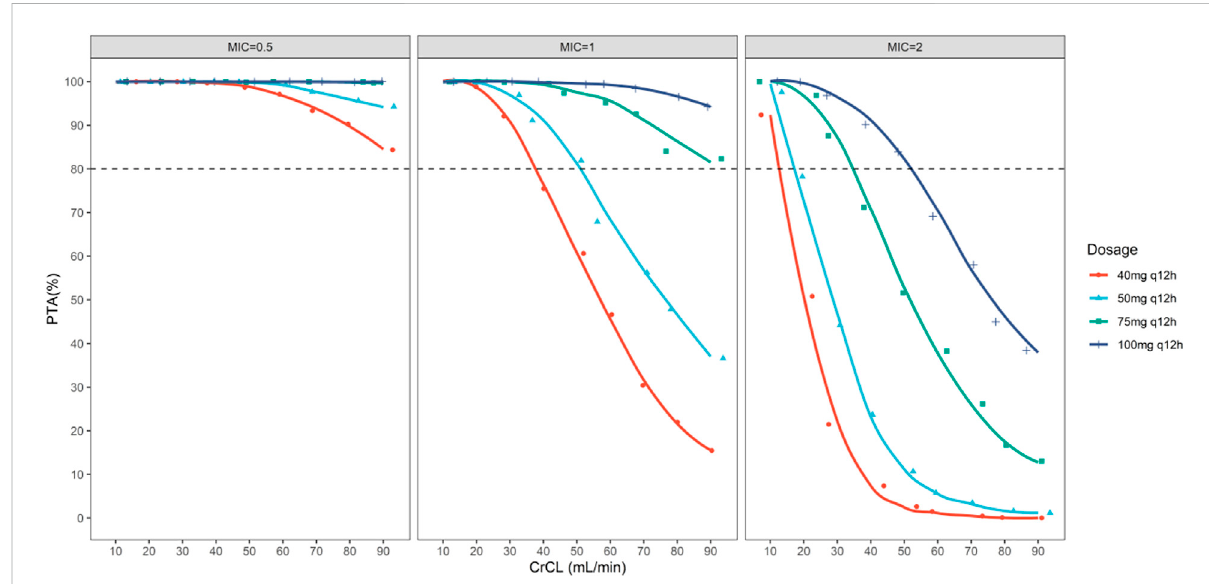
FIGURE 4 The simulated probability of target attainment (ef fi cacy target of fAUC/MIC ≥ 20) of polymyxin B on 40, 50, 75, and 100 mg q12h regimens in lung transplant patients with different creatinine